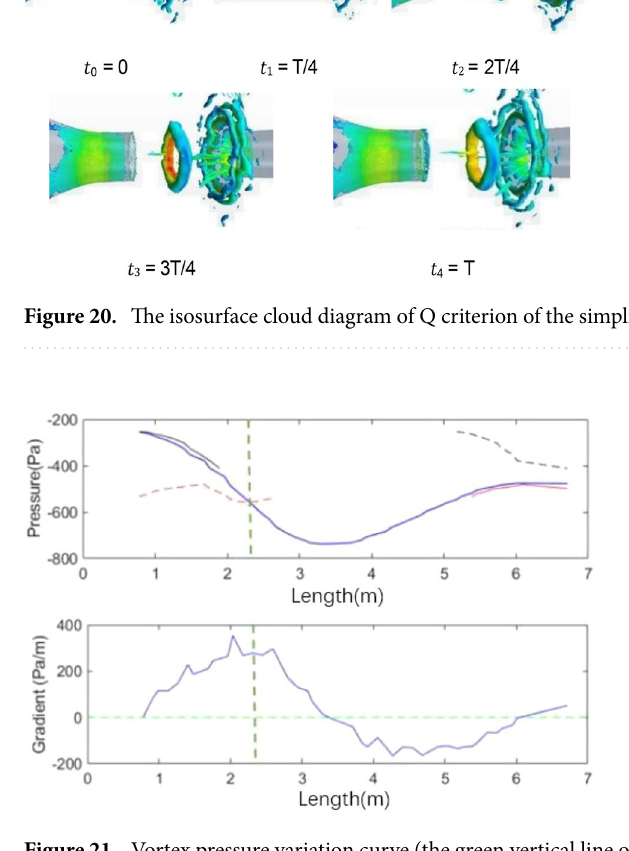
Figure 20 shows the isosurface cloud diagram of Q criterion in one cycle of the simplified model. The basic characteristics of the flow field of the simplified model are the same as those of the original wind tunnel, but clearer and simpler. The vortex structure of the nozzle jet is complete because the nozzle is circular. The forward speed of different positions of the vortex ring is the same, thereby avoiding the axis transformation of the rec- tangular jet and facilitating the follow-up study. Figure 21 shows the change process of a single vortex in the simplified model. The pressure change curve of the simplified model illustrates that the overall pressure still decreases first and then increases. The new vortex maintains a rapid growth before the two vortex pressures are equal, and the growth rate of new vortex pressure decreases after the two pressures are equal. The fitting of red line vortex and blue line vortex, red line vortex and black line vortex in the simplified model is better than the original model, showing that this simplified method can ensure higher similarity between cycles. The difference between the simplified model and the full-scale model is that the growth rate of the simplified model is high, reaching the extreme value of the pressure value in advance and maintaining for a certain time. The simplified model completely shows the three stages of vortex development: induced growth, passage, and survival, attenuation, and fragmentation. The comparison shows that the duration of each stage is affected by many factors and is related to the state of flow field. The induction of new vortex has nothing to do with whether the wake vortex reaches the minimum pressure or whether it decays and is affected by the resonance frequency. However, the growth rate of the new vortex is related to the change in the intensity of the wake vortex. No sud- den pressure change is observed in the simplified model. Figure 22 shows the development of black line vortex. In the simplified model, the development trend of vortices in different periods is highly consistent. The duration of each stage is similar. The induction time and position of black line vortex are consistent with that of blue line vortex, and the development at the end of blue line vortex is the same as that of red line vortex. Compared with the full-scale model, the simulation analysis has stronger periodic consistency, which is convenient for the subsequent modification work.